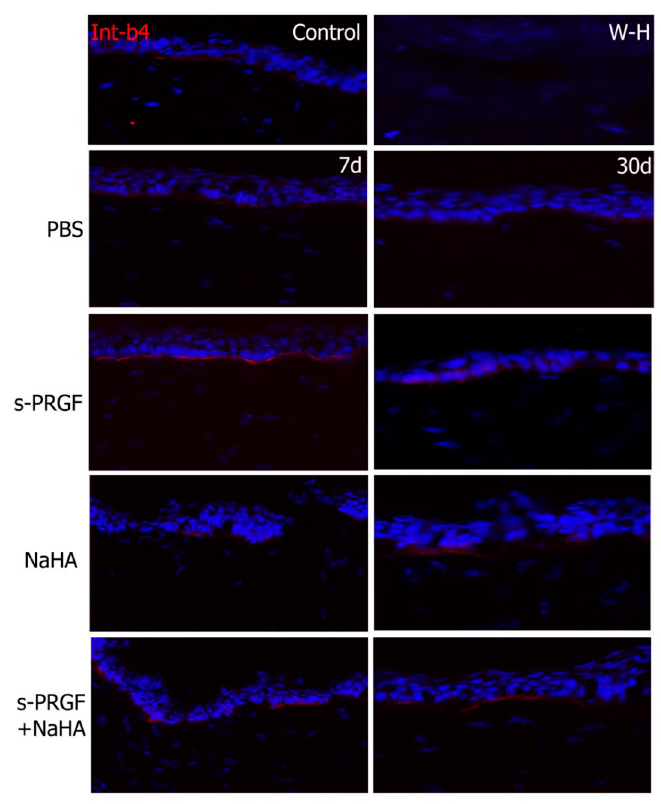
Figure 9. Fluorescent immunostaining for β 4 integrin on rabbit central corneas after healing of the epithelial defect. Rabbit corneas were treated with s-PRGF, s-PRGF and NaHA, NaHA, or PBS (as a control) and were processed 7 and 30 days after cornea surgery. Control corresponds to a healthy rabbit cornea with no surgery. The W-H image shows a cornea processed 48 h after surgery without complete re-epithelialization. Magnification 200 × . Table 2. Number of Ki67 positive cells in rabbit corneas treated with s-PRGF, s-PRGF and NaHA, NaHA, and PBS as the control. The results are expressed as mean number of cells ± standard deviation in seven different areas of the central corneas at 7 and 30 days after